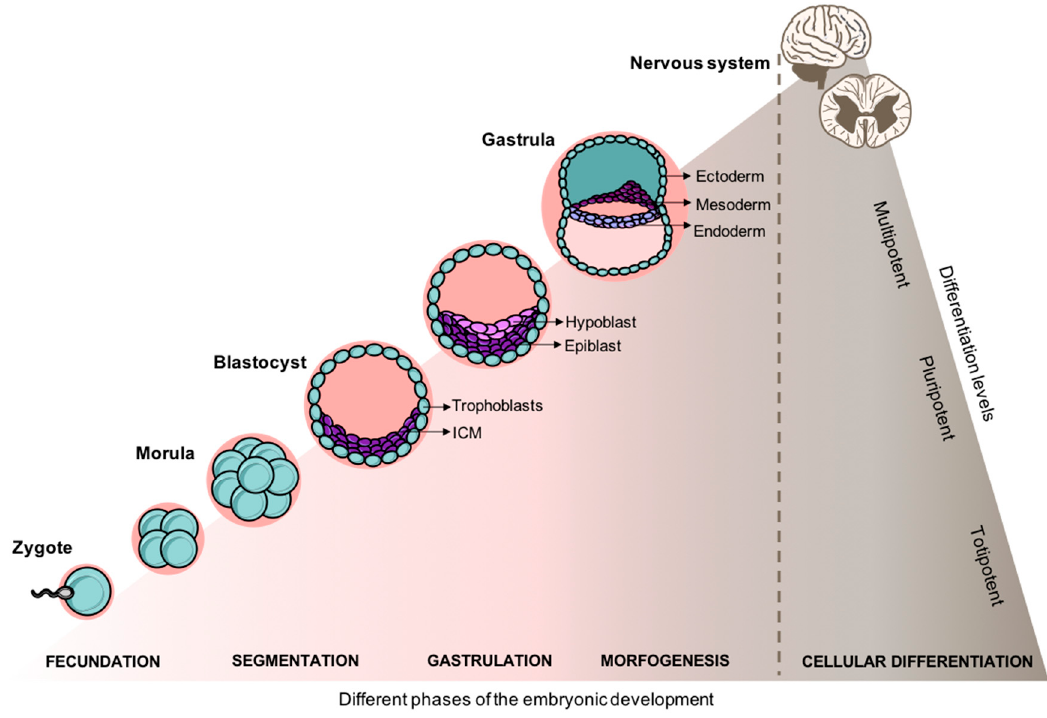
Figure 2. Embryonic development and cellular differentiation. After fecundation, the entire embryogenesis is spatially and temporally coordinated dynamically shifting the gene expression, cell growth, and cellular differentiation.